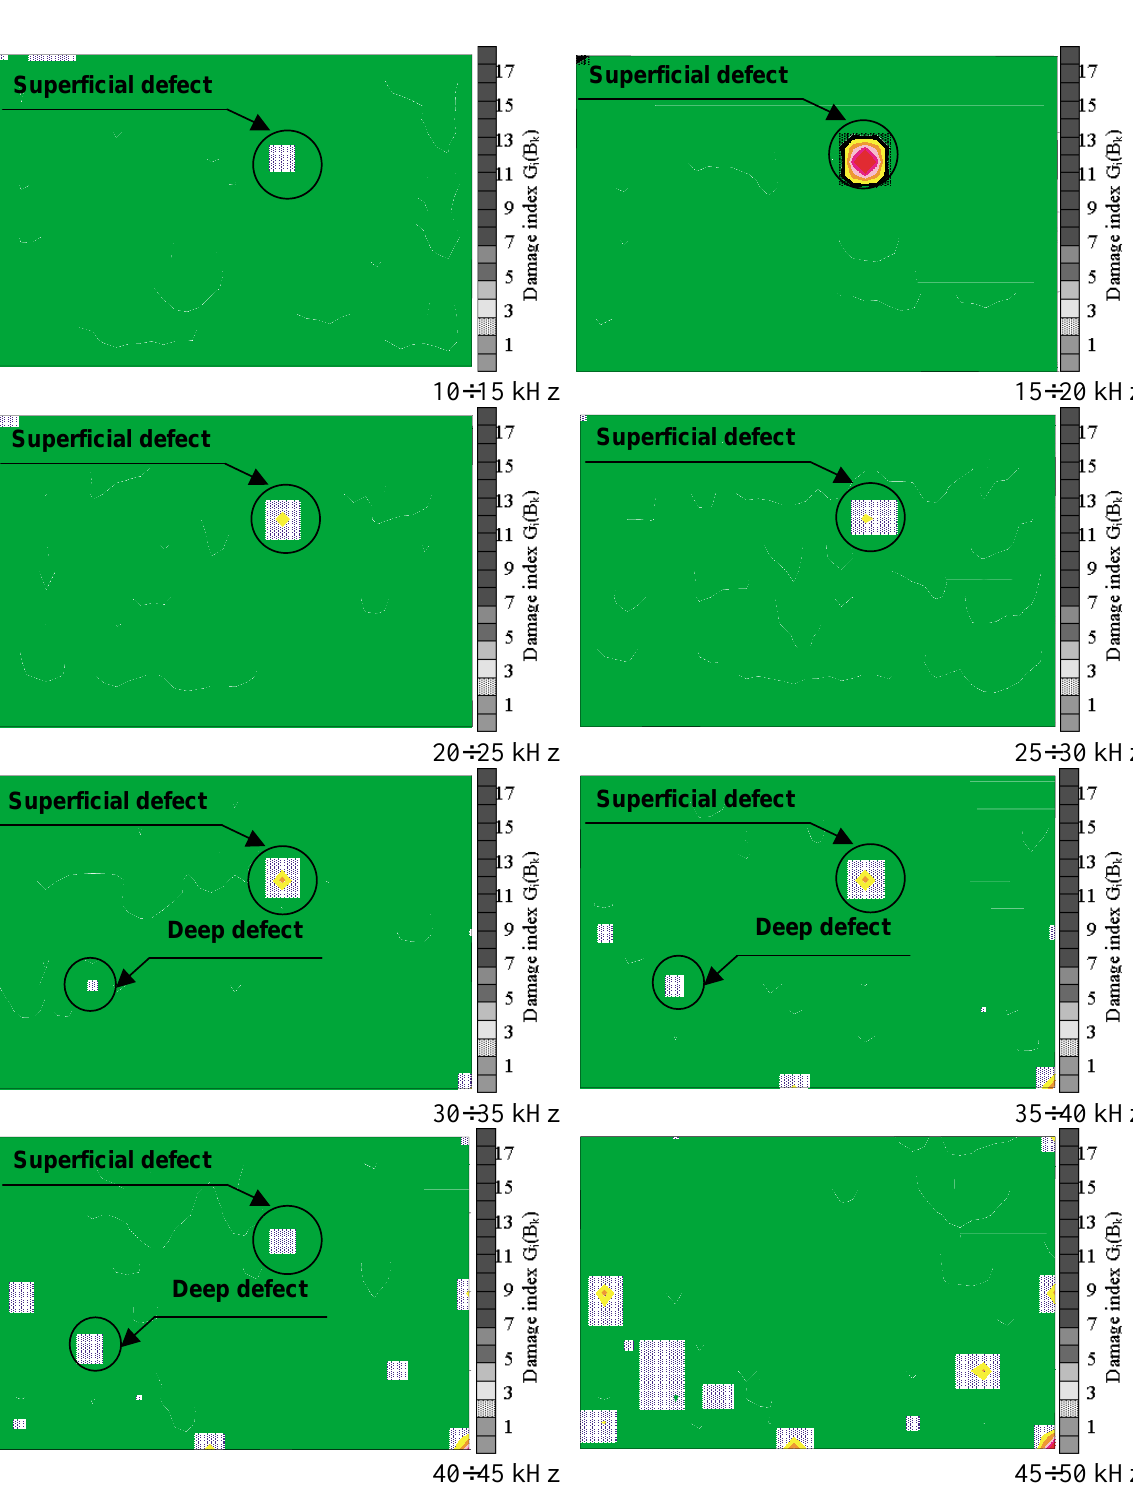
Fig. 9. Damage Index maps on the aluminium plate in different frequency